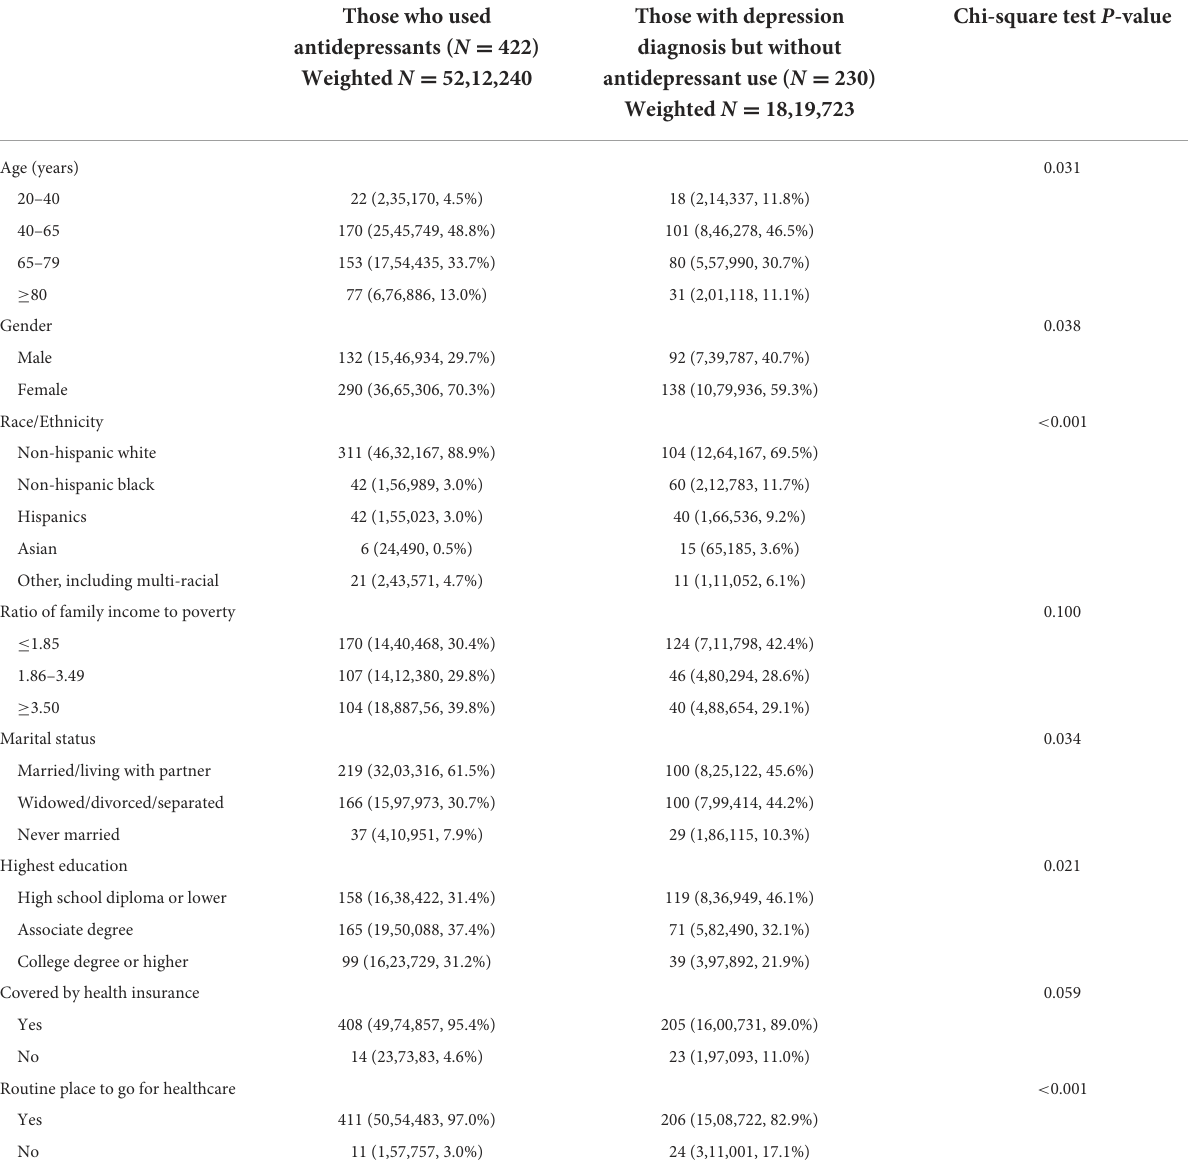
TABLE 2 Social-demographic characteristics and access to healthcare by antidepressant use in adult cancer survivors in the United States. Those who used Those with depression Chi-square test P antidepressants ( N = 422) diagnosis but without Weighted N = 52,12,240 antidepressant use ( N = 230) Weighted N = 18,19,723